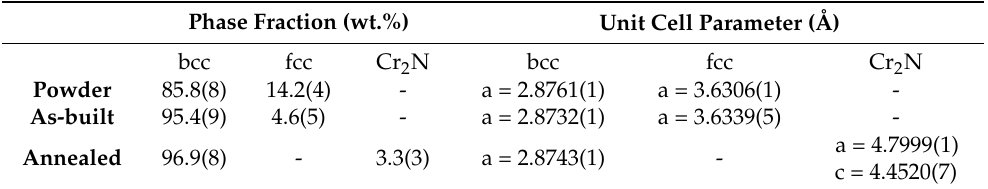
Table 2. Estimated amount of the phases and their cell parameters from Rietveld refinements. Phase Fraction